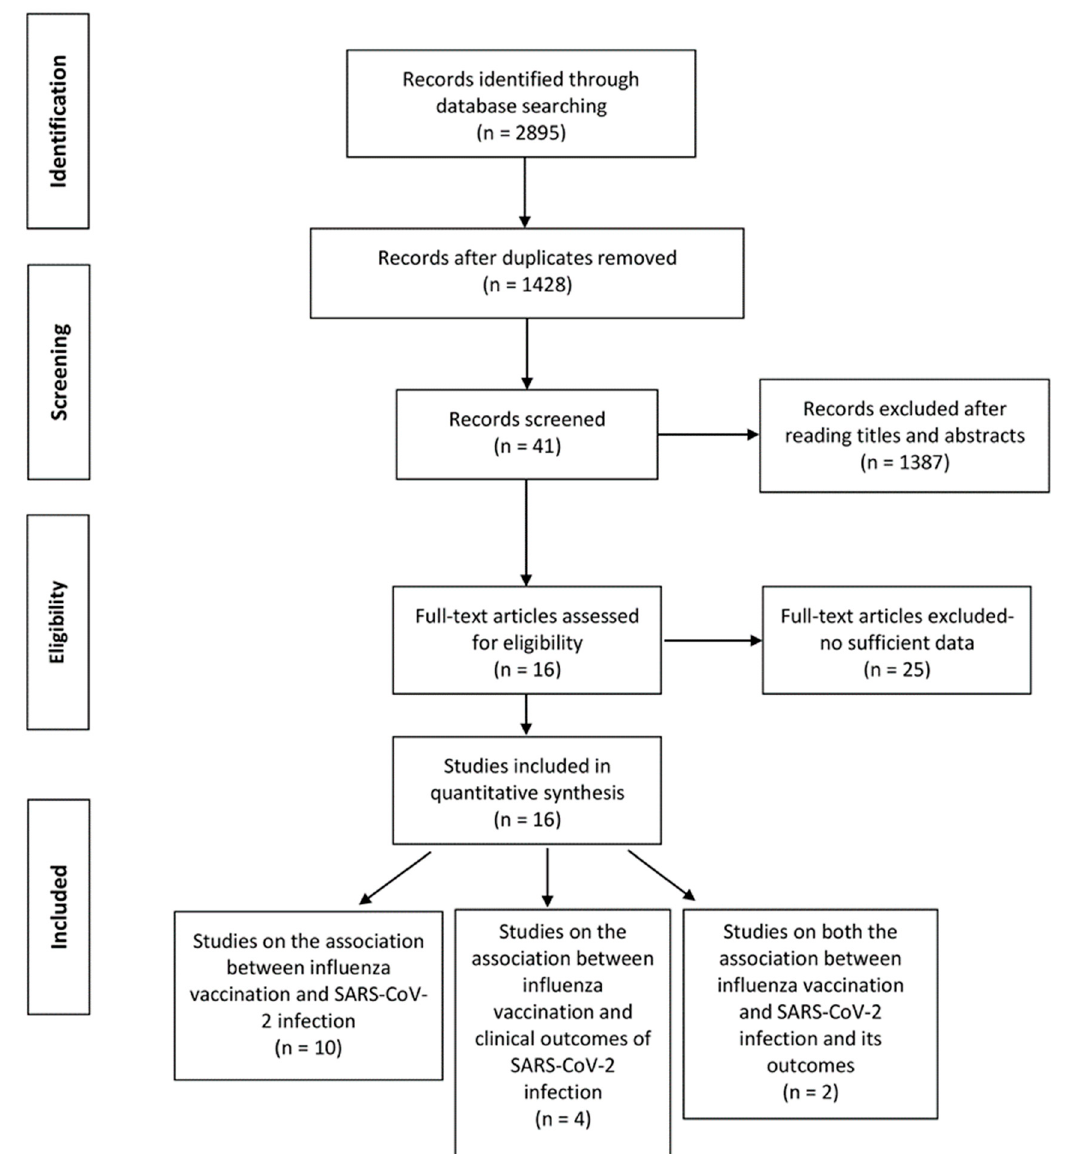
Figure 1. PRISMA flow diagram of the study selection procedure. Table 1. Baseline characteristics of the 12 included studies that assessed the association between influenza vaccination and SARS-CoV-2 infection.